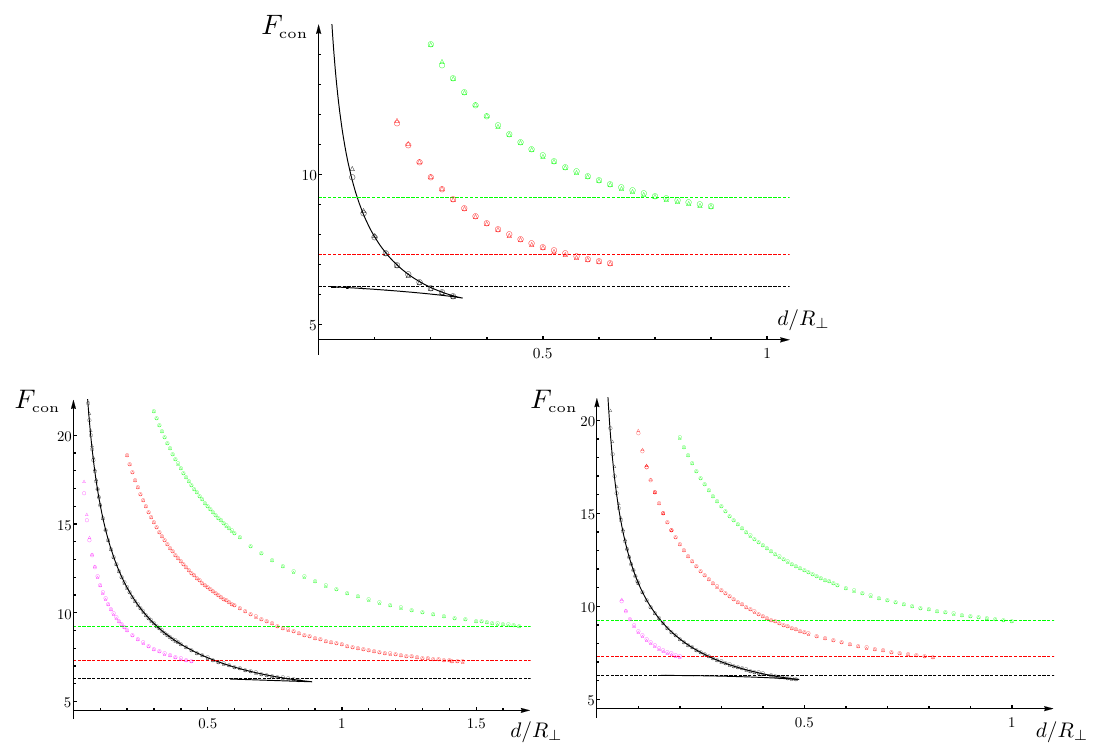
Figure 13 . The subleading term F for the extremal surfaces ^ (cid:13) con intersecting orthogonally the con A half plane Q and anchored to ellipses at distance d from a (cid:13)at boundary (see (cid:12)gure 12). A semiaxes of the ellipse is orthogonal to the (cid:13)at boundary and its length is R ? , while R is the length of the k other one. The three panels are characterised by three diverse values of the slope (cid:11) for the half plane Q (see (cid:12)gure 12): (cid:11) = (cid:25)= 2 (top), (cid:11) = 2 (cid:25)= 3 (bottom right) and (cid:11) = 3 (cid:25)= 4 (bottom left). Di(cid:11)erent colours correspond to di(cid:11)erent eccentricities: R = 3 R ? (green), R = 2 R ? (red), R = R ? (black) k k k and R = 0 : 5 R ? (magenta). The solid black curves correspond to the analytic expressions obtained k in section 4.2 for disks. The dashed horizontal lines provide the value F A = F for the extremal dis surfaces disconnected from Q . In particular, F = 9 : 25 (green), F = 2 (cid:25) (black) and F = 7 : 33 dis dis dis (red and